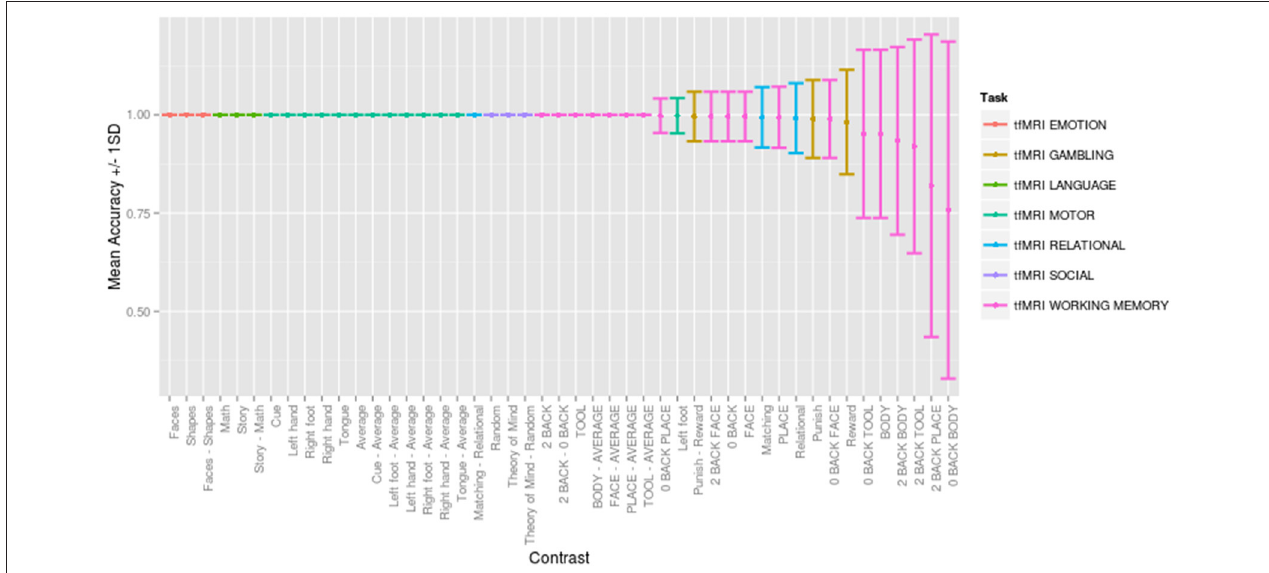
FIGURE 4 | Mean accuracy ± 1.0 standard deviation for each contrast across 500 random folds for the optimally performing threshold ( Z = ± 1.0), direction (positive and negative), comparison strategy (complete case analysis) and similarity metric (Pearson score). Interactive confusion matrices for all thresholds, comparison strategies, and similarity metrics are available (http://vsoch.github.io/image-comparison-thresholding).